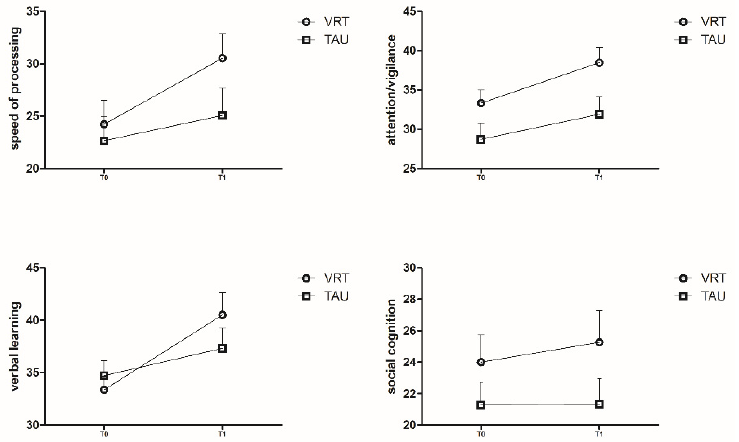
Figure 4. Legends: Figure 4 Line chart showing the changes of SP, AV, VeL, and SC T cores be- tween T0 (VRT: 24.23 ± 12.46, 33.33 ± 9.18, 33.37 ± 7.14 and 24.00 ± 9.51; TAU: 22.66 ± 13.17, 28.72 ± 11.52, 35.56 ± 15.19 and 21.28 ± 8.38) and T1 (VRT: 24.23 ± 12.46, 38.47 ± 10.35, 40.50 ± 11.60